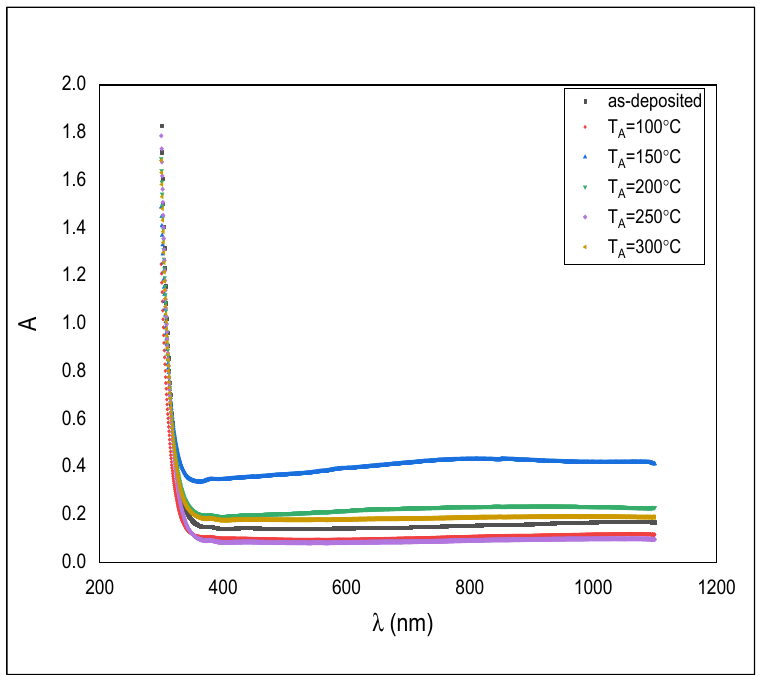
Figure 5. Absorbance spectra for the as-deposited and annealed ZnS films. All samples displayed higher absorbance in the UV region rather than near the IR region. The absorbance is just somewhat in the visible region. That makes the material beneficial as a windscreen covering and driving mirror to forestall the impact of striking light into a driver’s eyes from an approaching vehicle and following vehicle. The transmittance measurements of the films were done using UV/VIS spectropho- tometer and are shown in Figure 6.